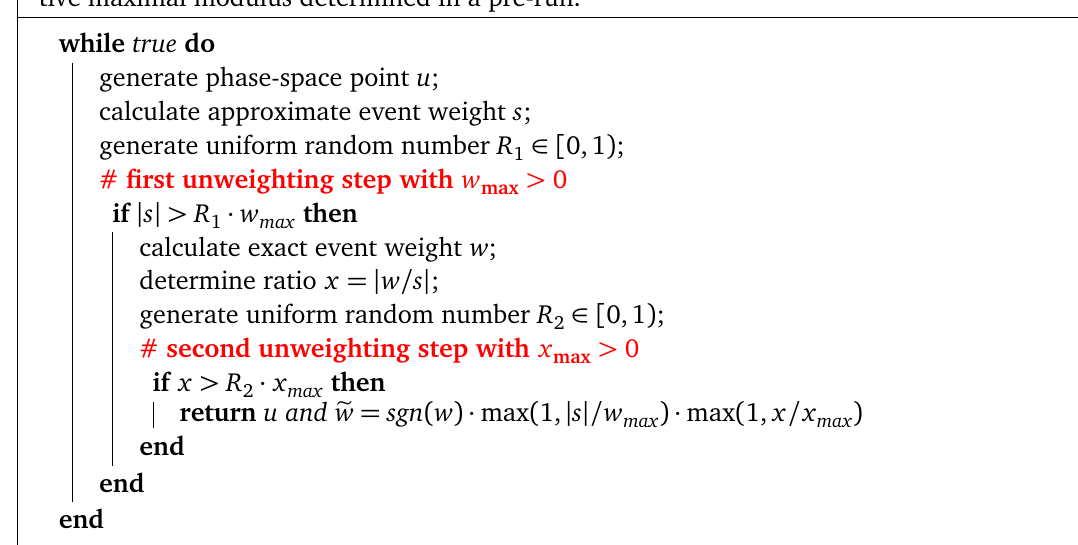
Algorithm 4: Two-stage rejection-sampling algorithm, allowing for negative